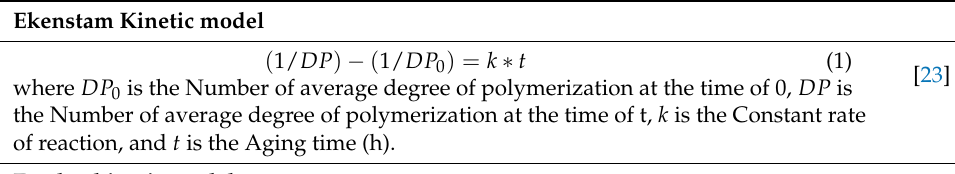
Table 1. Kinetic models of cellulose solid